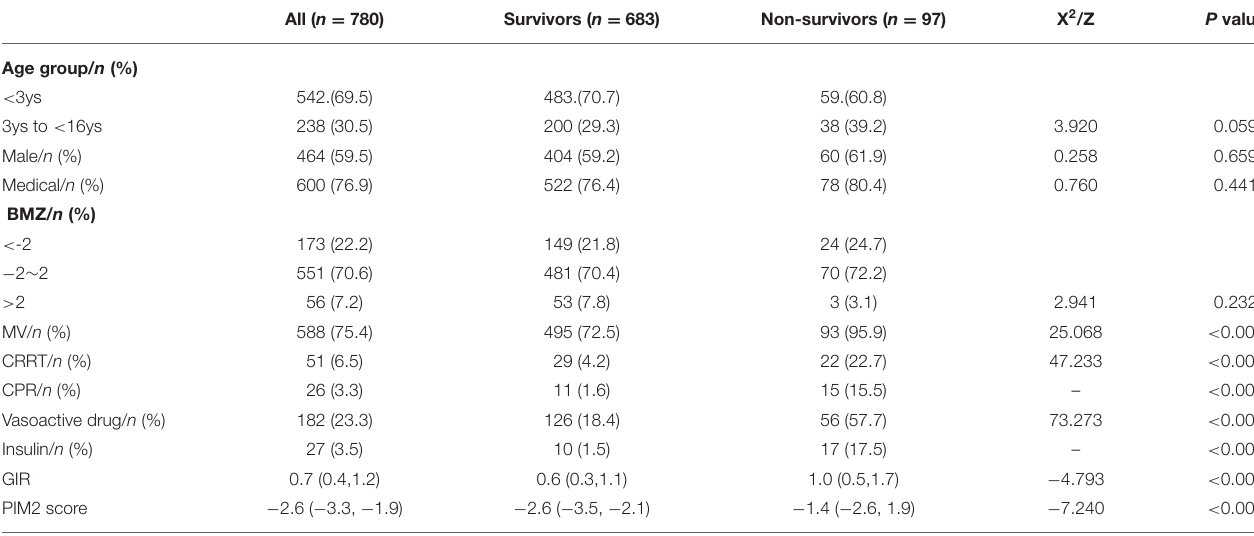
TABLE 1 | The comparison of baseline variables between survivors and non-survivors[M (P25, P75), n (%)]. All ( n = 780)